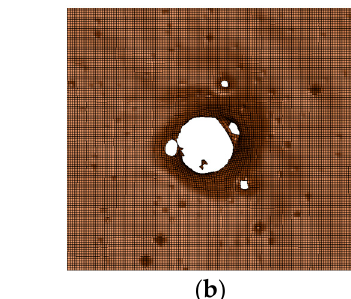
( c ) Figure 9. Bullet holes in steel target plates: ( a ) schematic diagram of bullet hole, ( b ) front of target plate, and ( c ) back of target plate. 3.1. Validation of Numerical Simulation Results Numerical calculations were carried out for the projectile impacting the target plate with different velocities. Compare the numerical calculation results with the test results. Figure 10 shows the results for a projectile velocity of 760 m/s and the target plate